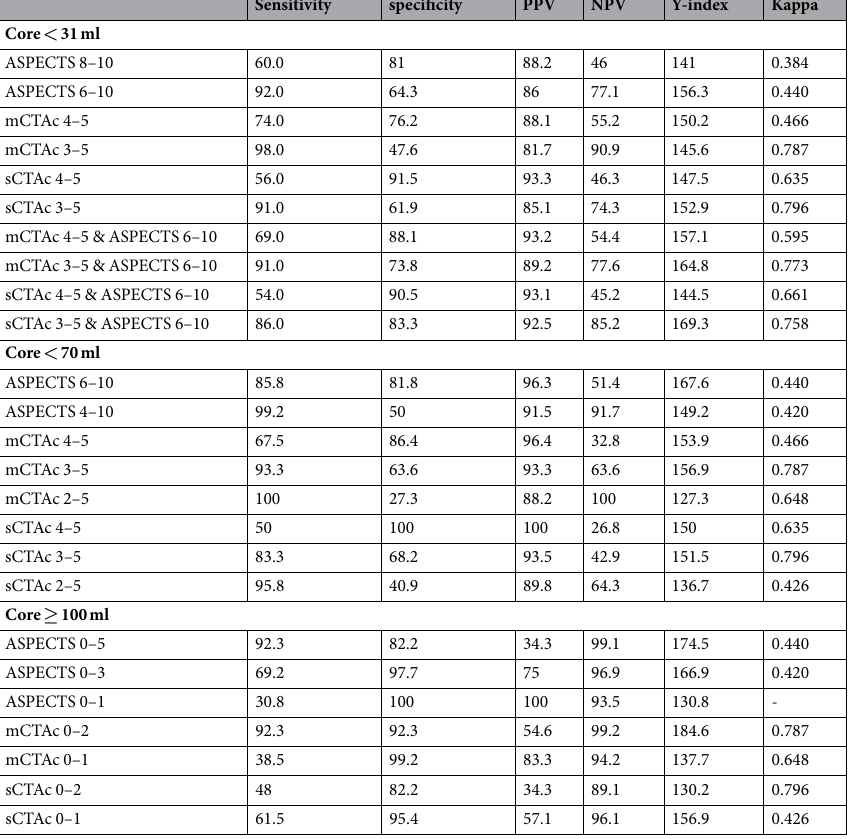
Table 2. Predictive performance of mCTA collaterals, sCTA collaterals, ASPECTS, and combination of collateral imaging and ASPECTS in predicting core volume thresholds of < 31 ml, < 70 ml, and ≥ 100 ml, and its inter-rater reliability. mCTAc, multiphase CT angiography collaterals; sCTAc, single-phase CT angiography collaterals; ASPECTS, Alberta stroke program early CT score; PPV, positive predictive value, NPV, negative predictive value; Y-index, Youden’s